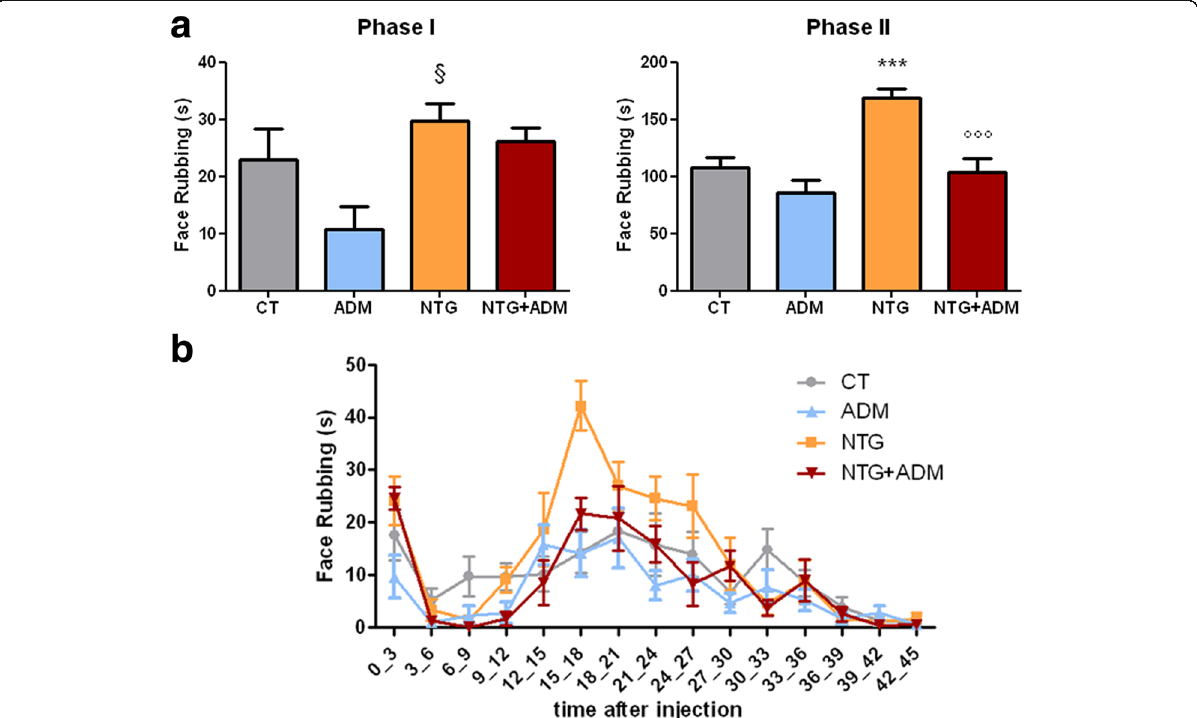
Fig. 1 Orofacial formalin test. a Total time (seconds) spent in face rubbing in Phases I and II. NTG administration significantly increased nocifensive behavior in Phase II as compared to control group (CT). No difference was found in Phase I. ADM_12 administration did not provoke any significant changes during either phase of the test when used with NTG vehicle (ADM group). When ADM_12 was administered in association with NTG (NTG + ADM group), it prevented NTG-induced increase in nocifensive behavior in Phase II. b Time course of the face rubbing. Data are expressed as mean ± SEM. ANOVA followed by Tukey ’ s Multiple Comparison Test, § p < 0.05 vs ADM; *** p < 0.001 vs CT and ADM; °°° p < 0.001 vs